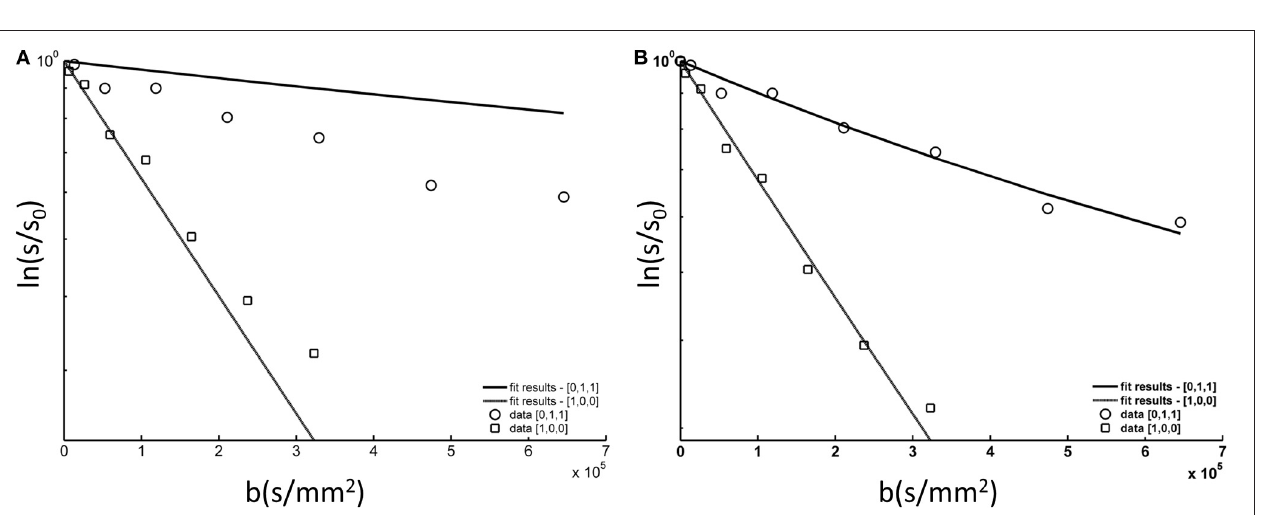
FIGURE 6 | tNAA DWS data from a single subject (symbols) fitted to the model described in the methods section and in step (A) in Figure 3. (A) The data fitted to the model with one fitting variable, D(tNAA), and